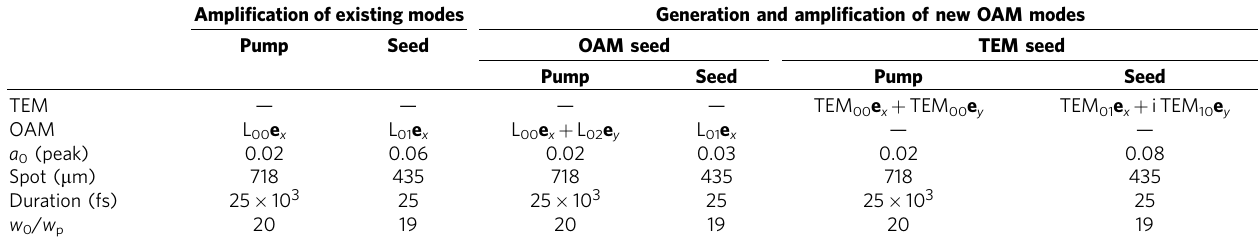
Table 1 | Laser parameters for the different Raman Amplification regimes to generate and amplify OAM lasers.